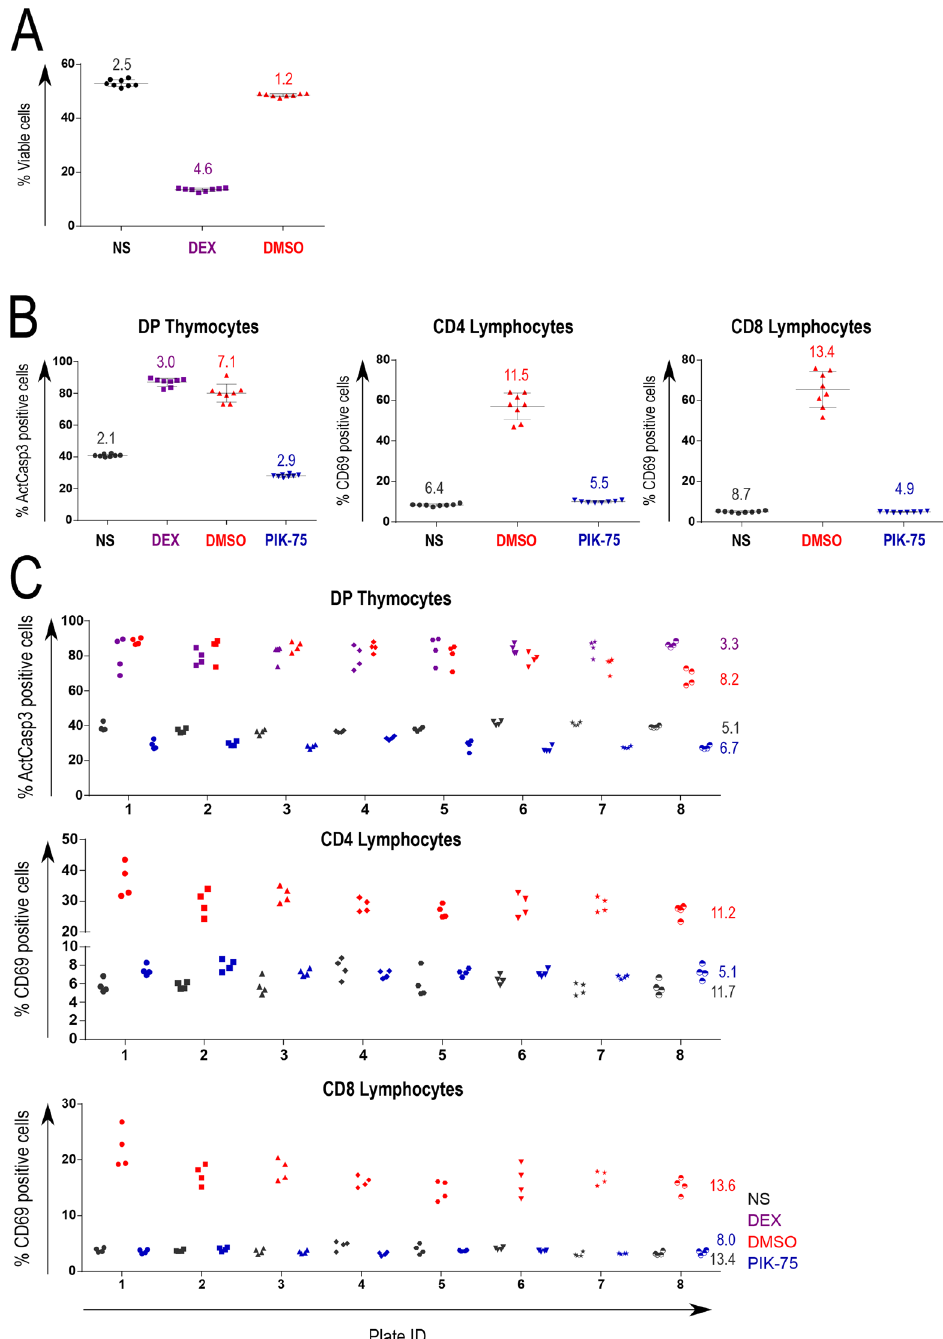
Figure 5. Reproducibility of screening assays. ( A ) Technical replicates for the positive (DEX: dexamethasone, purple symbols) and negative controls (NS: not stimulated, black symbols; and DMSO, red symbols) of the viability assay. Cells were assayed in eight replicates per condition by flow cytometry. The graph depicts primary data points, mean, and SD. Coefficients of variation (CV) are indicated for each data set. (B) Technical replicates for the positive and negative controls (NS: not stimulated, black symbols; DEX: dexamethasone, purple symbols; DMSO: TCR stimulation in the presence of DMSO, red symbols) and an assay compound (TCR stimulation in the presence of PIK-75; blue symbols), in thymocyte and lymphocyte assays. Caspase 3 activation in thymocytes (left panel) and CD69 upregulation in CD4 and CD8 lymphocytes (middle and right panel) were analyzed as in Figs 3 and 4. Cells were assayed in eight replicates per condition by flow cytometry. The graph depicts primary data points, mean, and SD. CV values are indicated for each data set. (C) Technical replicates for the positive and negative controls (NS: not stimulated, black symbols; DEX: dexamethasone, purple symbols; DMSO: TCR stimulation in the presence of DMSO, red symbols) and an assay compound (TCR stimulation in the presence of PIK-75; blue symbols), across individual plates. Cells were assayed in four replicates per plate per condition, in eight individual plates, by flow cytometry. CV values between plates is indicated for each data